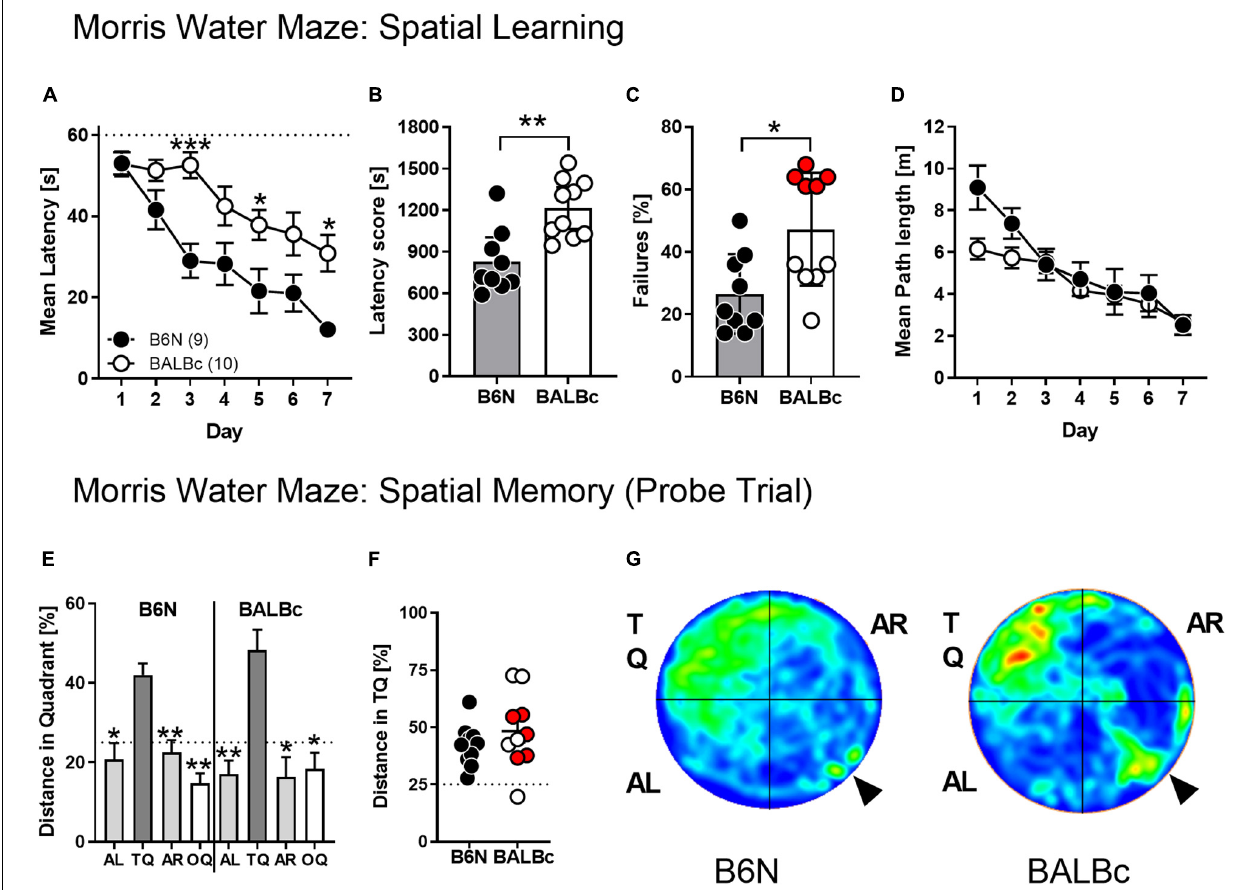
FIGURE 4 | BALBc mice showed increased escape latencies but intact spatial memory in the MWM. To analyze the cognitive performance in a more demanding spatial navigation task, 10 weeks old B6N ( n = 9) and BALBc ( n = 10) mice were trained in the MWM over the course of 7 days with 4 training trials per day, followed by a probe trial at day 8 whereby the hidden platform was removed from the NW quadrant (TQ). (A,B) BALBc mice show longer escape latencies throughout training, which (C) is reflected by a higher number of trials in which the animals failed to reach the platform within 60 s (marked in red: subset of BALBc mice with particularly pronounced failure rate). The strain differences were not reflected if (D) the swimming path lengths during training and (E–G) the selectivity of spatial memory assessed in the probe trial were considered (AL, adjacent left quadrant; AR, adjacent right quadrant; OQ, opposite quadrant; TQ, target